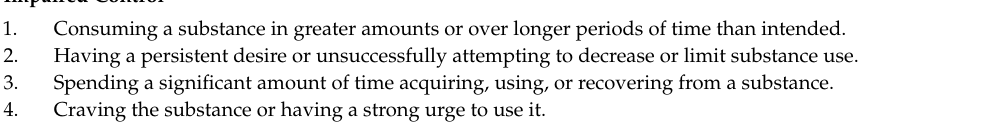
Table 2. Substance Use Disorder criteria, adapted from the Diagnostic and Statistical Manual of Mental Disorders, 5th Edition (DSM-5)